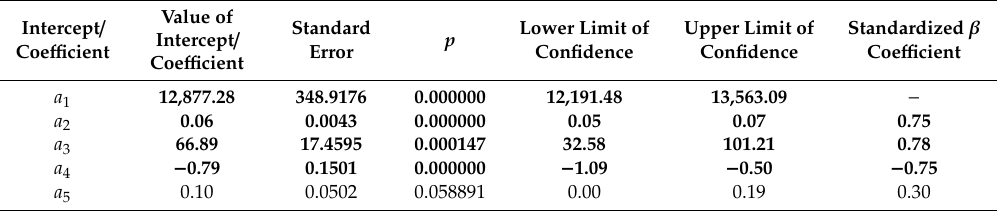
Table A3. Statistic evaluation of 3D model parameters of LHV (model 2).